Question: Summarize what this figure shows in one sentence.
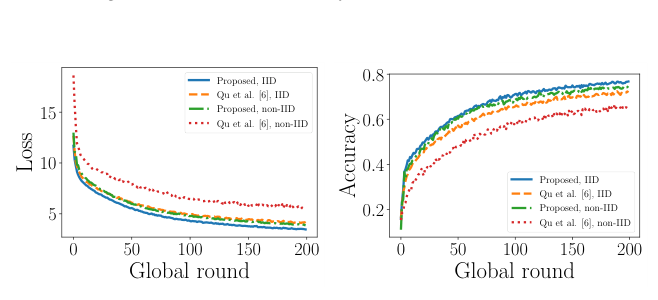
Answer: Loss and accuracy with CIFAR-10 dataset.